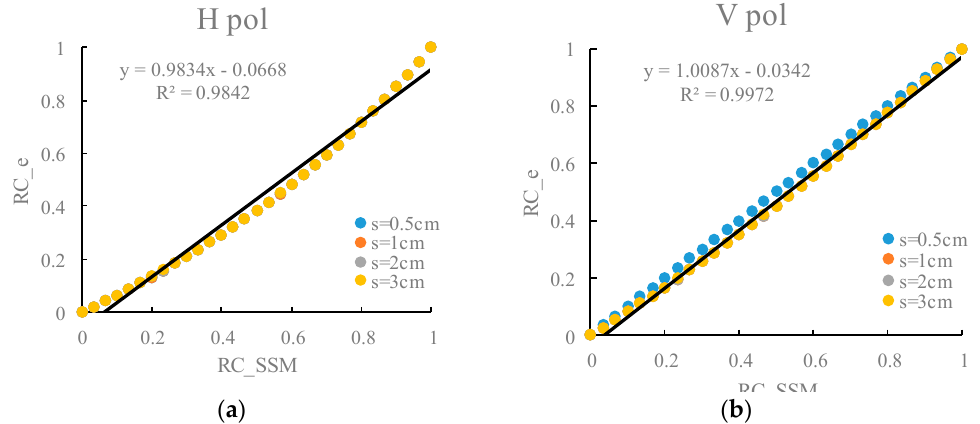
Figure 2. The relationship between the relative change of SSM (RC_SSM) and surface reflectivity (RC_e) for horizontal ( a ) and vertical ( b ) polarization for various surface roughness conditions (cl = 10 cm, s = 0.5 cm, 1 cm, 2 cm and 3 cm).